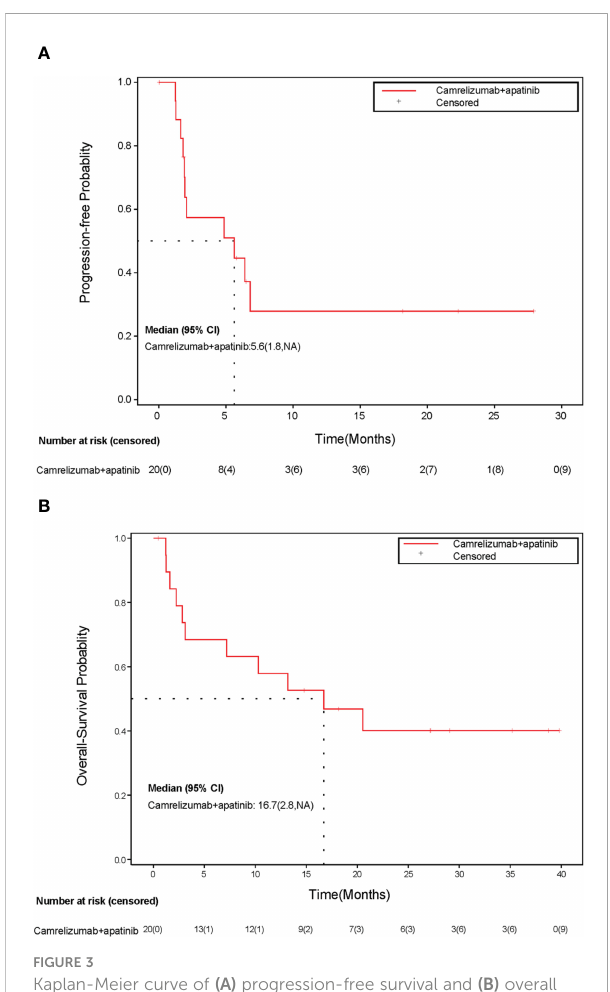
FIGURE 3 Kaplan-Meier curve of (A) progression-free survival and (B) overall survival. CI, con fi dence interval; NA, not